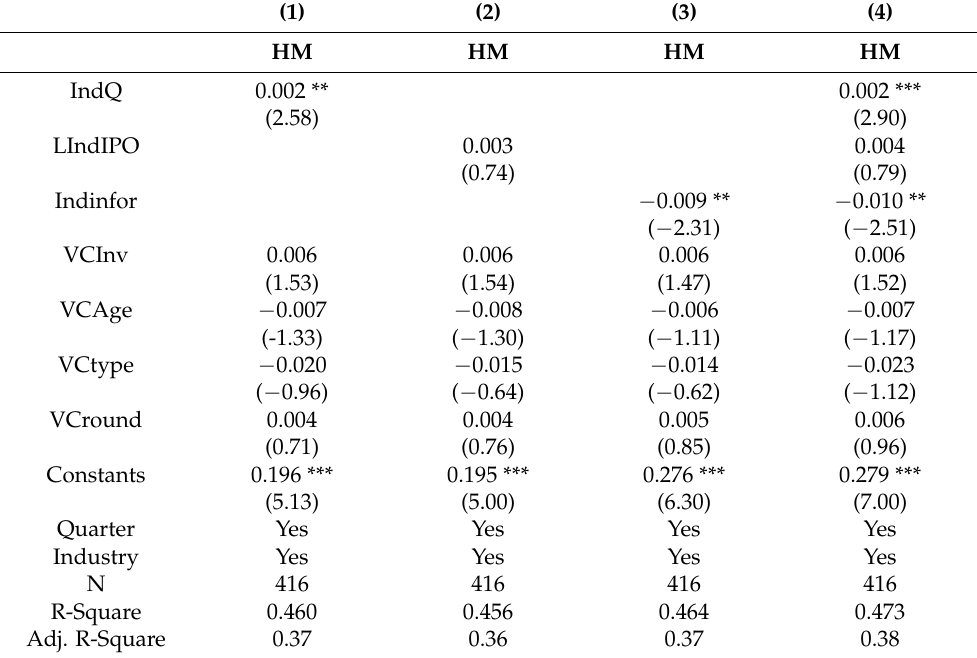
Table 4. Causes of herding among venture